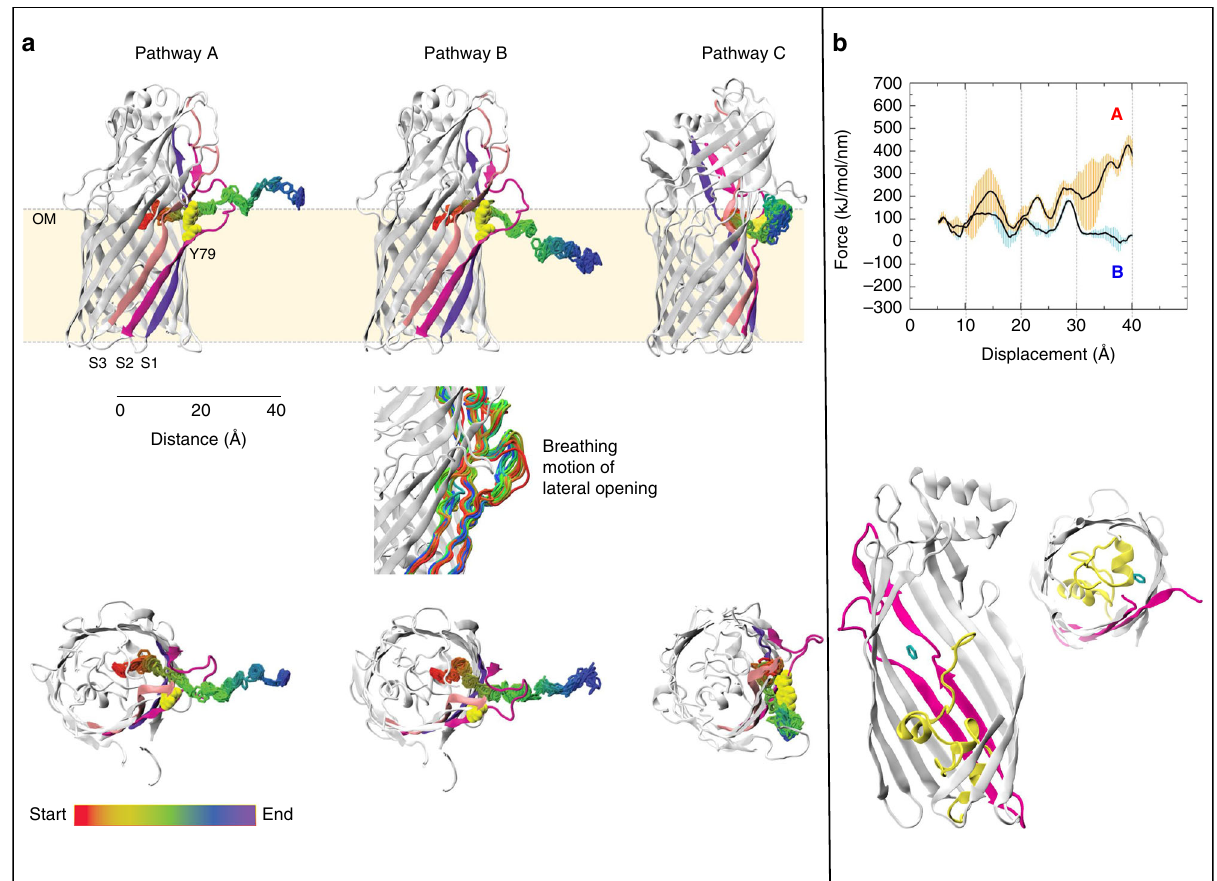
Fig. 7 Identi fi cation of three distinct benzene pathways into the OM through the lateral opening in TodX. a Views from the side (top panel) and from the extracellular side (bottom panel), showing locations of benzene molecules from 250 equally spaced frames for each simulation, according to the colour scheme indicated. The middle panel shows the breathing motion of the lateral opening during benzene exit via pathway B. b Force pro fi les corresponding to pathways A and B (top panel) and views of the initial location of benzene for the equilibrium simulations (bottom). Standard deviations are shown in orange and